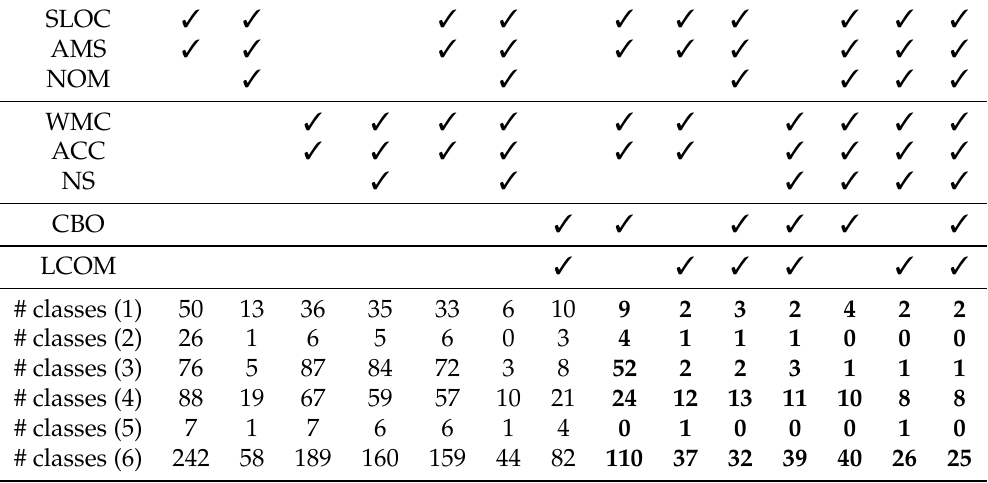
Table 7. Number of identified classes within Notepad++ (1); Money Manager (2); 7-Zip